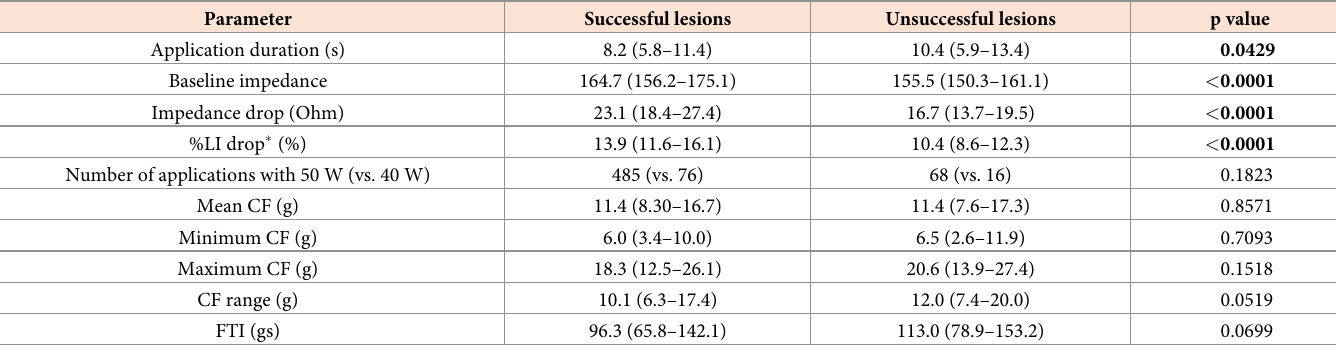
Table 2. Characteristics of the successful and unsuccessful